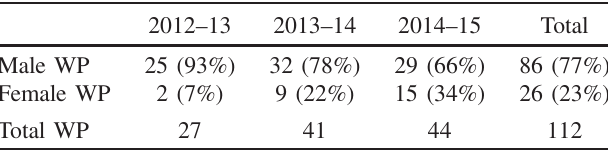
TABLE IV. WP students, including gender split, of 2012 – 13 through 2014 – 15